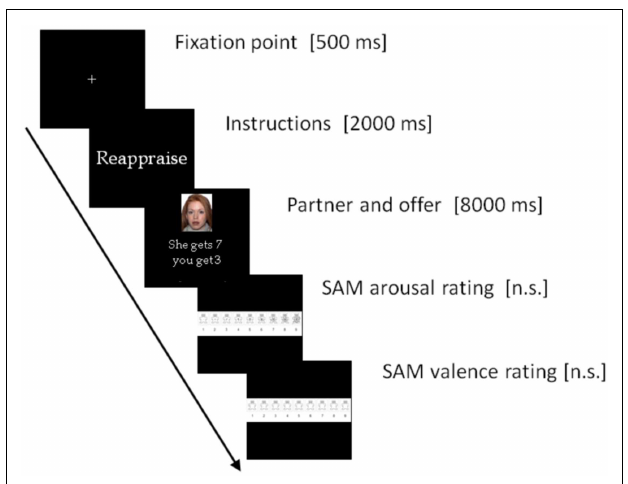
FIGURE 1 |A timeline of the events presented on each trial. Subjects’ responses on valence and arousal ratings were recorded.